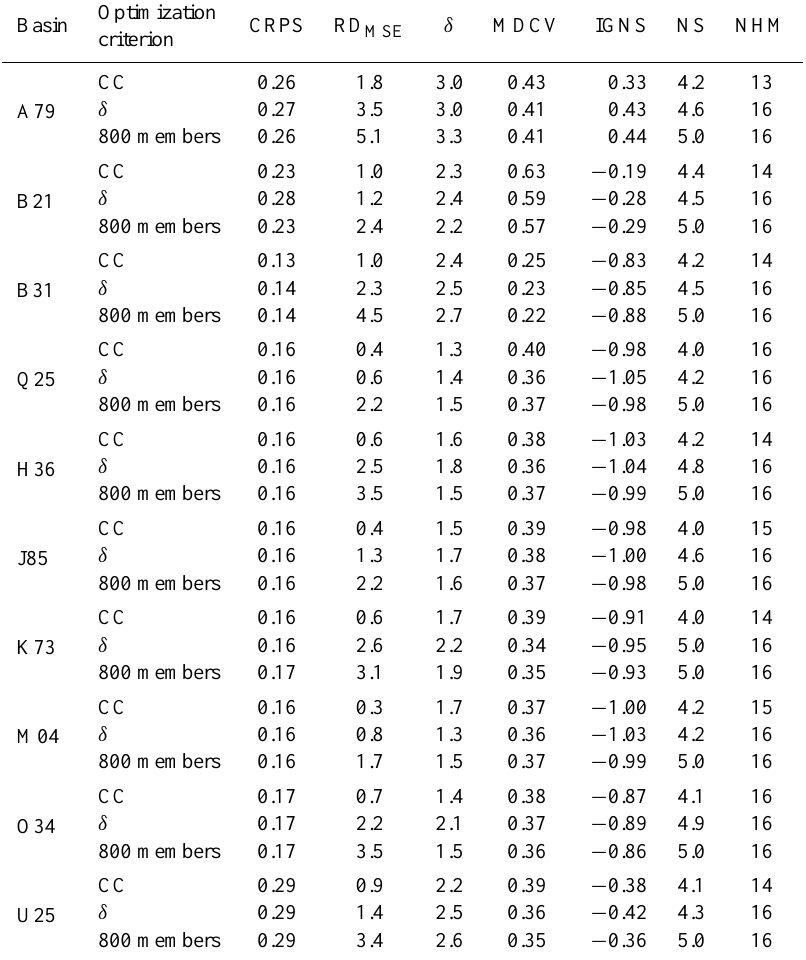
Table 7. Selection of 100 hydrological members based on the combined (CC) and δ criteria. NHM indicates the number of hydrological models participating in the